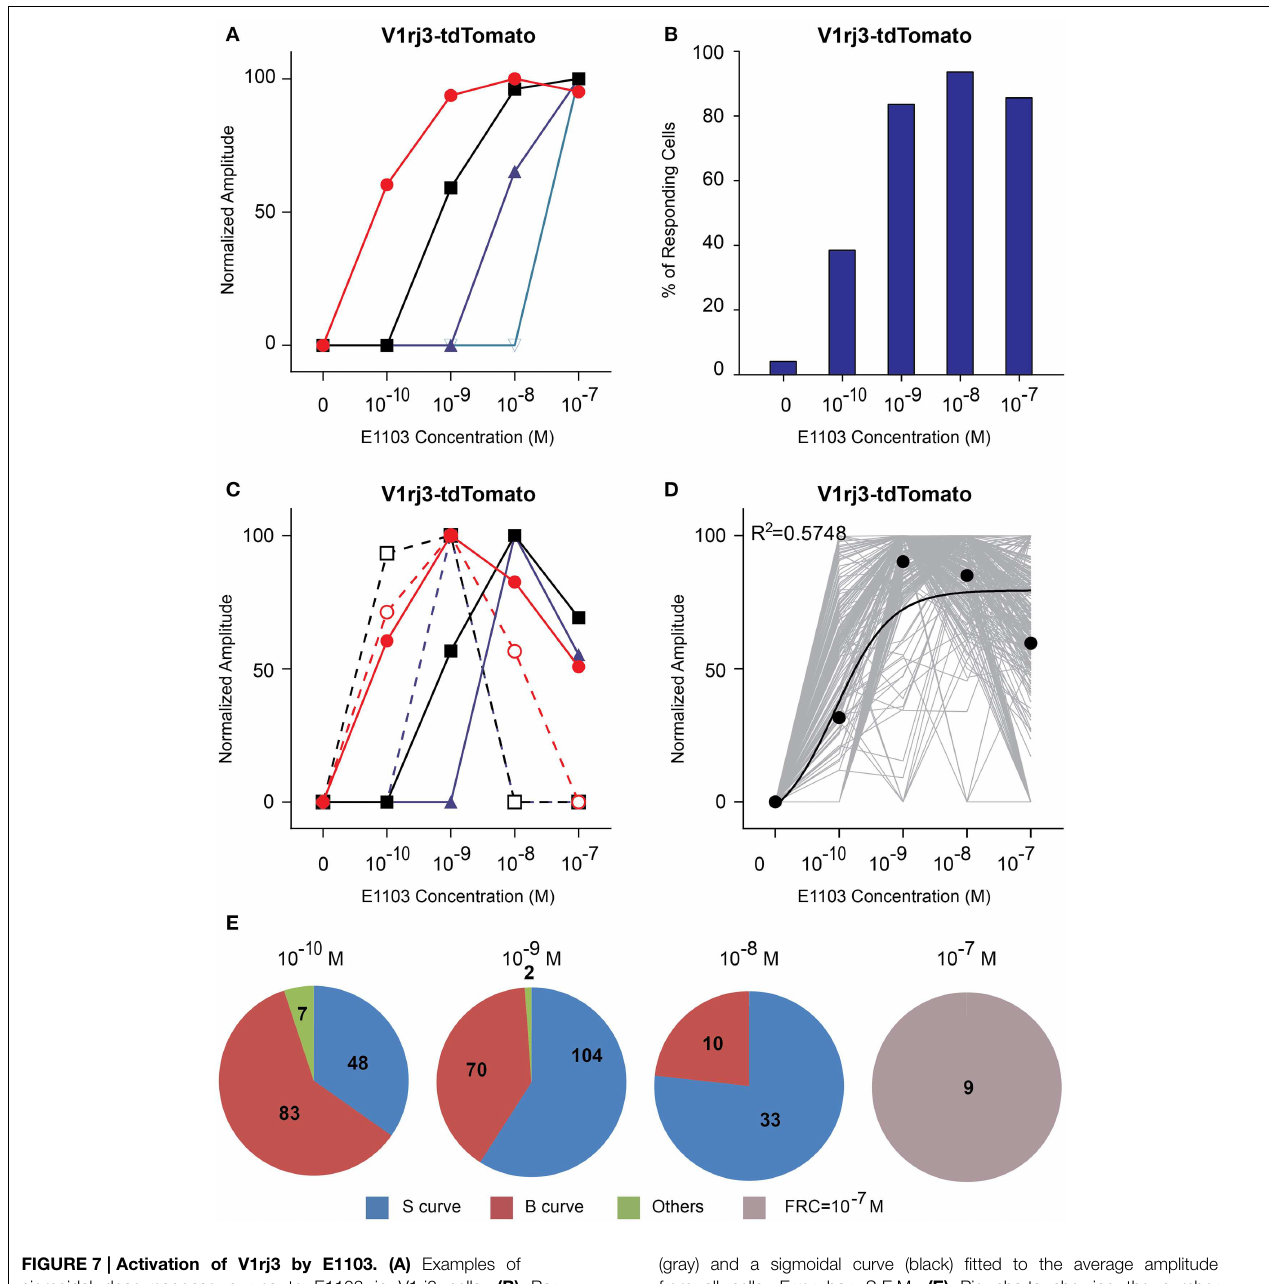
FIGURE 7 | Activation of V1rj3 by E1103. (A) Examples of sigmoidal dose-response curves to E1103 in V1rj3 cells. (B) Bar graph showing the percentage of E1103 activated V1rj3 cells ( n = 256 ). (C) Examples of bell-shaped dose-dependent responses of V1rj3 cells to E1103. (D) Dose-response curves of individual cells